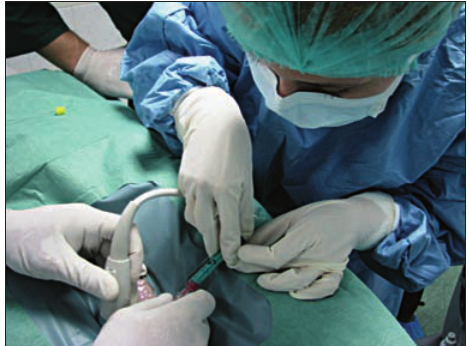
Fig. 2. In utero transplantation using the ultra- sound-guided transabdominal percutaneous needle puncture technique